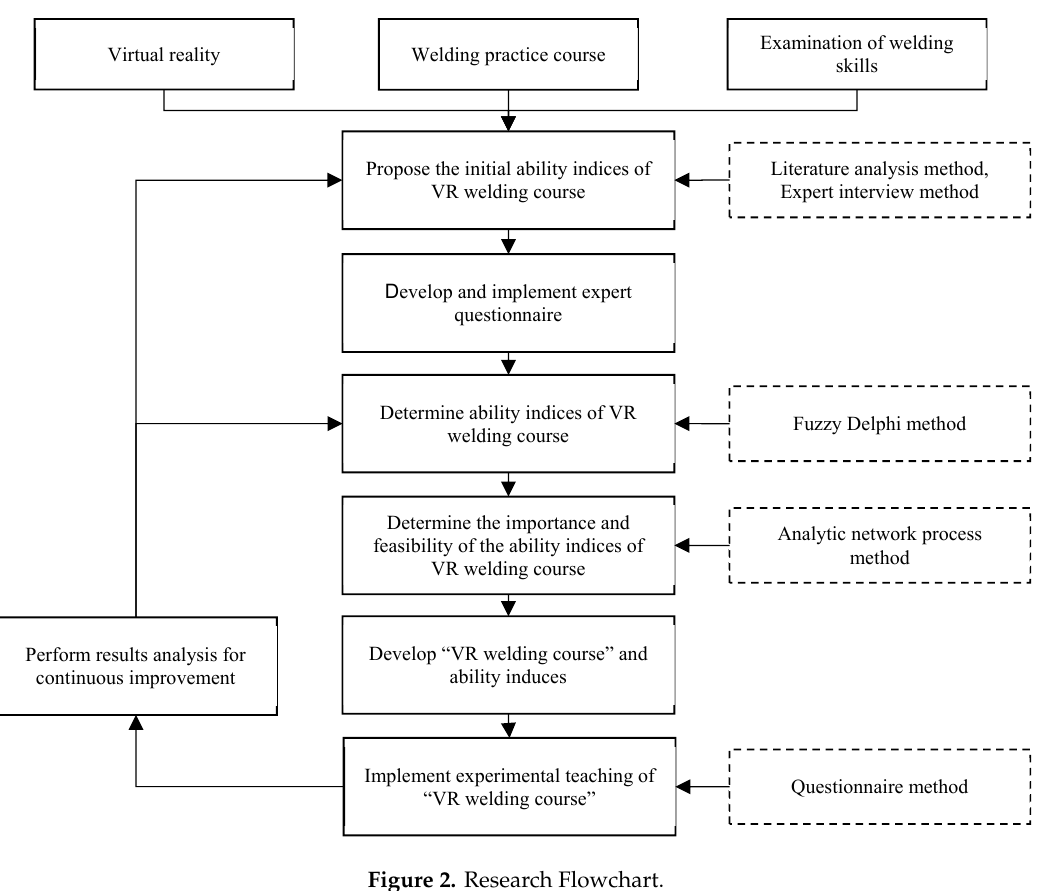
Figure 2. Research Flowchart.